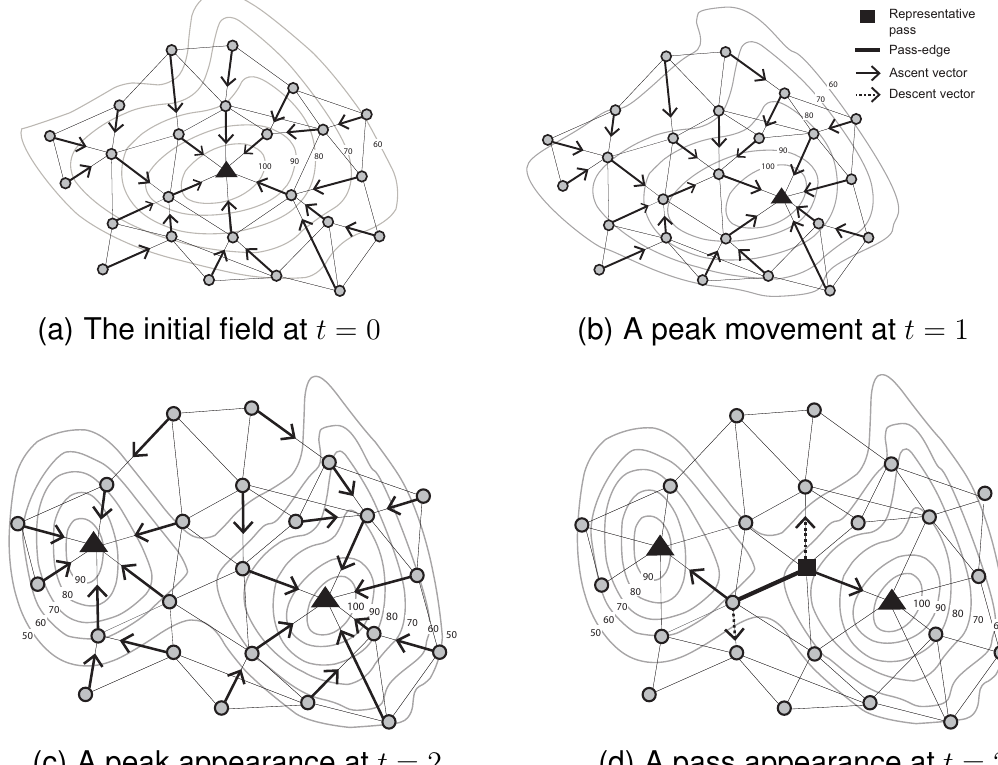
Figure 4. Monitoring events occurring on critical points between two consecutive time